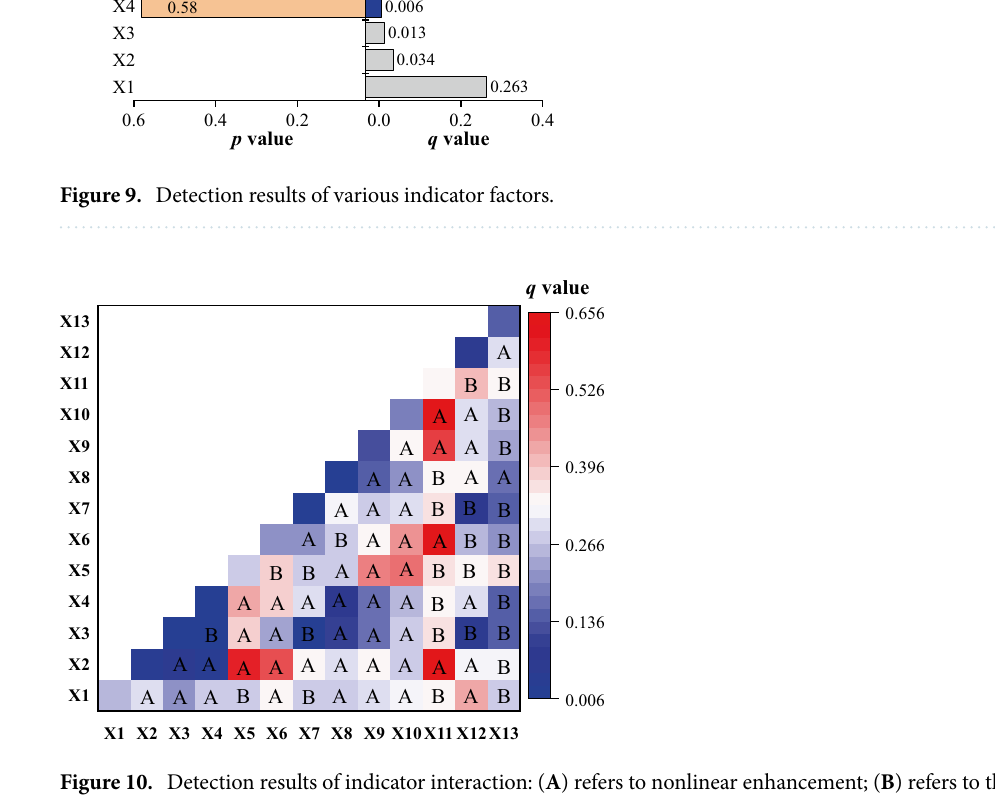
interaction of mining intensity (X11) with indicators including NDVI (X10), terrain slope (X2), annual average evaporation (X6) and land utilization (X9) sees a nonlinear enhancement effect, whereas sees linear enhance- ment with other indicators. In addition to mining intensity, the interaction of terrain slope (X2), annual aver- age precipitation (X5) and annual average evaporation (X6) with other indicators also enhance their ability in interpreting the eco-environmental quality of the study area. Overall, the interactive effect of various factors on eco-environmental quality cannot be considered a simple superposition but a linear or nonlinear enhancement. Impact of linearity and nonlinearity of indicators. Risk detection can reflect the linear and nonlinear variation of mining area ecology and the environment with a specific indicator. As shown in Fig. 11, the horizontal axis represents the zone levels of each indicator. The eco-environmental quality changes linearly with the zoning grades of geomorphology, mining intensity and surface subsidence, but nonlinearly with other indicators. Surface elevation and terrain slope share similar nonlinear characteristics; with the increase of zoning levels, mine eco-environmental quality experiences a decrease-increase process, as shown in Fig. 11a,b. In terms of terrain aspect, the less sunny side of a slope tends to show higher eco-environmental quality because of lesser evaporation and stronger ability to retain moisture, as shown in Fig. 11c. Figure 11e,g,j show wavelike increases in eco-environmental quality with annual average precipitation, aquifer specific yield and NDVI, indicating suf- ficient precipitation, shallow water resource and high vegetation coverage are conducive to the development of ecology and environment. Annual average evaporation and population density show a negative effect, indicated by Fig. 11f,l. Also, Fig. 11h,i exhibit that eco-environmental quality is closely related to river system distance and land utilization; when the area is 458.9 to 618.4 m away from a river and used as forestry land, it shows higher eco-environmental quality.